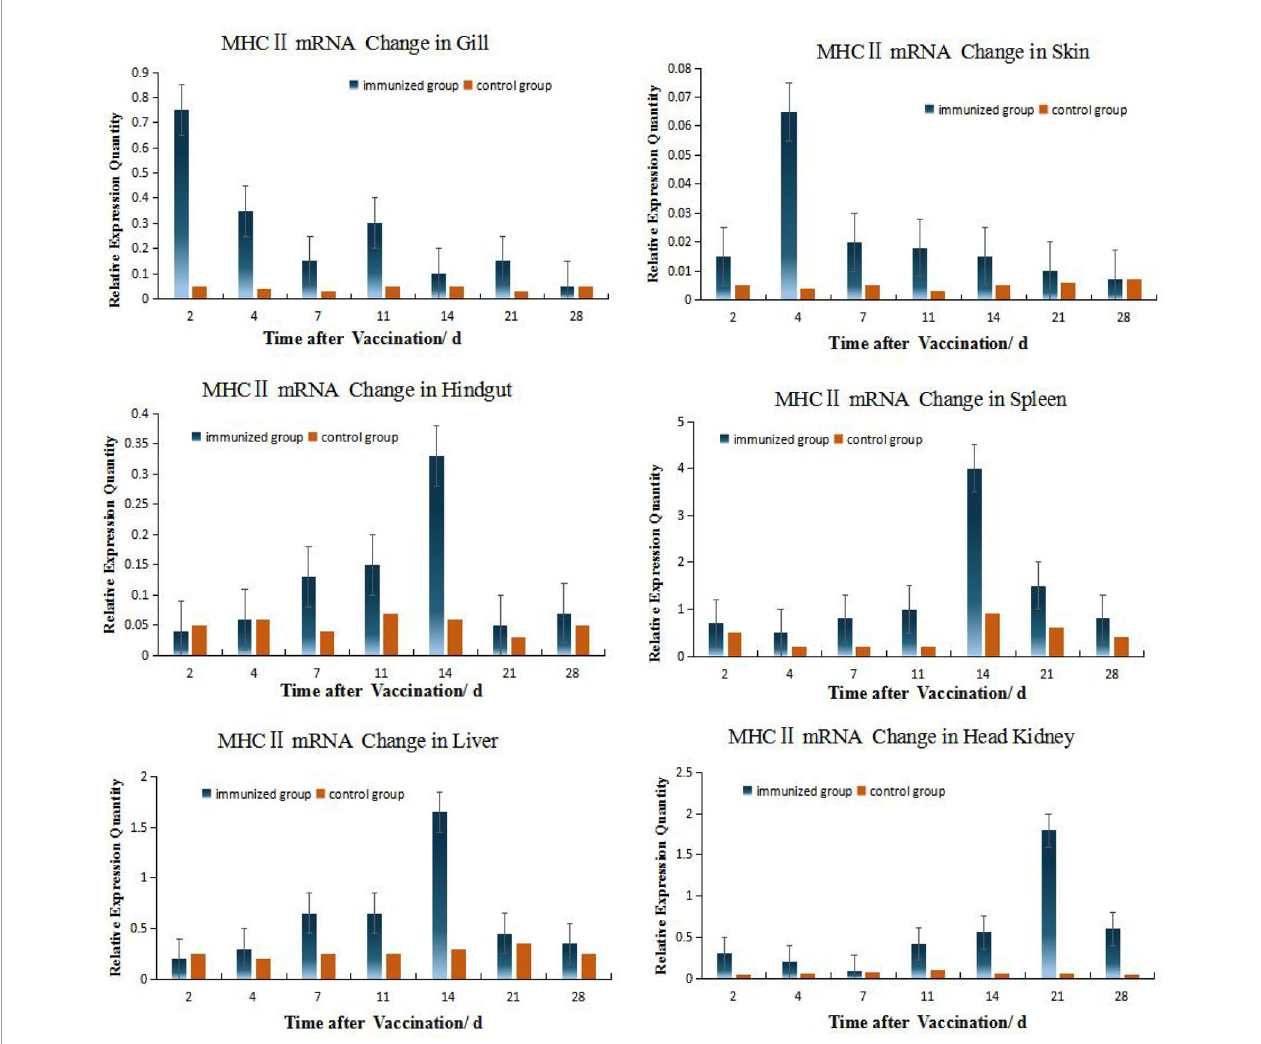
FIGURE 4 | Relative quanti fi cation of grouper MHC II gene mRNA in different organs. The relative abundance for MHC II mRNA from the tissues was ranked as spleen > HK> liver>gill> hindgut>skin. The alterations in mRNA levels over time were similar for the hindgut, liver, and spleen with increases at day 14 post- inoculation. Organ MHC II mRNA expression levels changed with time and the hindgut, liver and spleen followed the same temporal